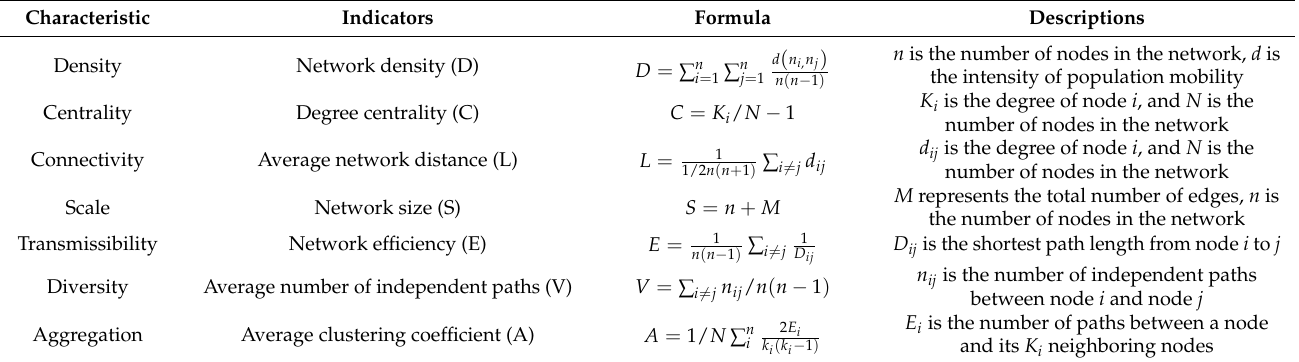
Table 1. Measuring the index of network